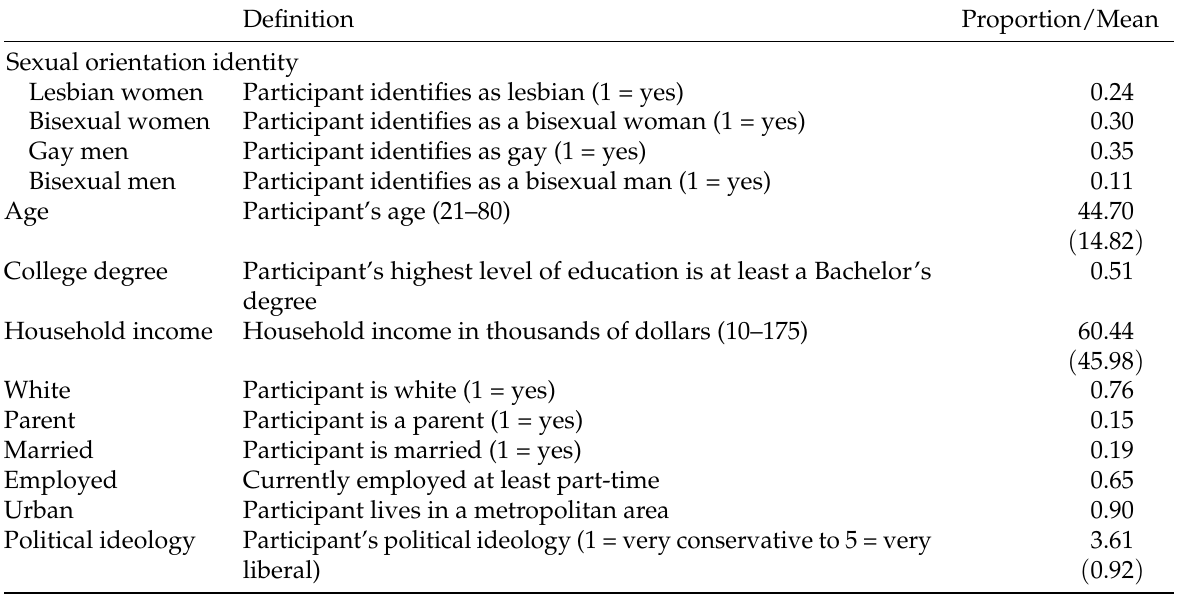
Table 1: Sample descriptive statistics ( N = 1,